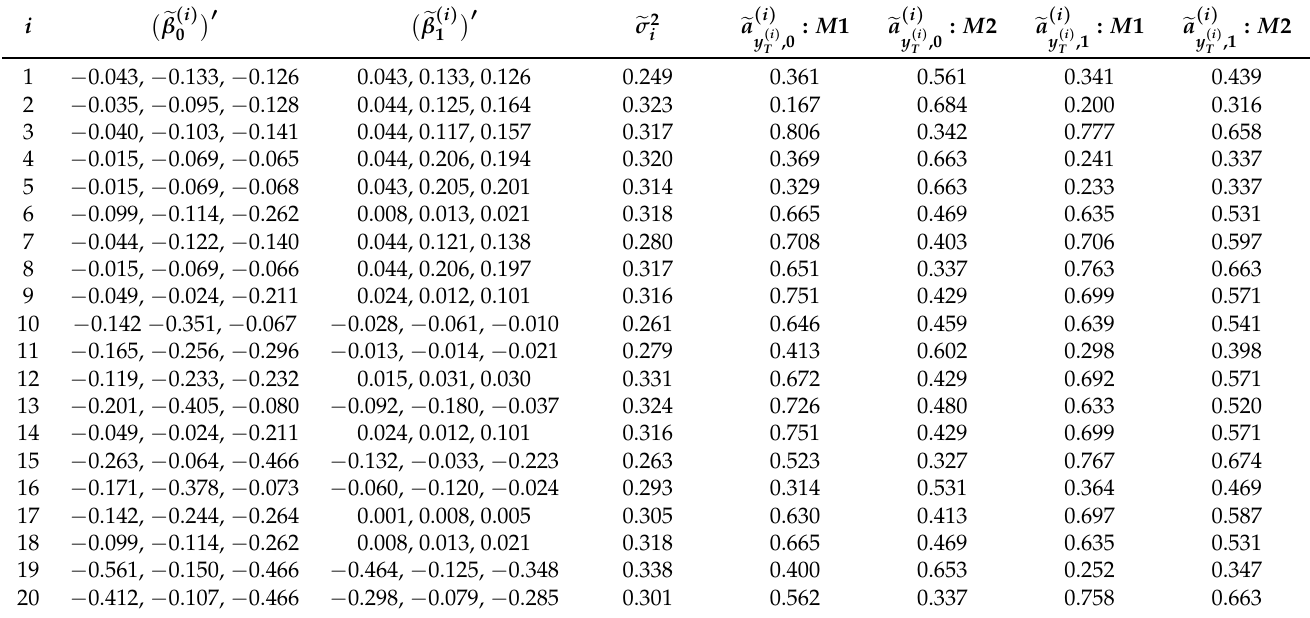
Table 2. Spatially weighted estimators of the HMM parameters for 20 AUs IR = 0.7.